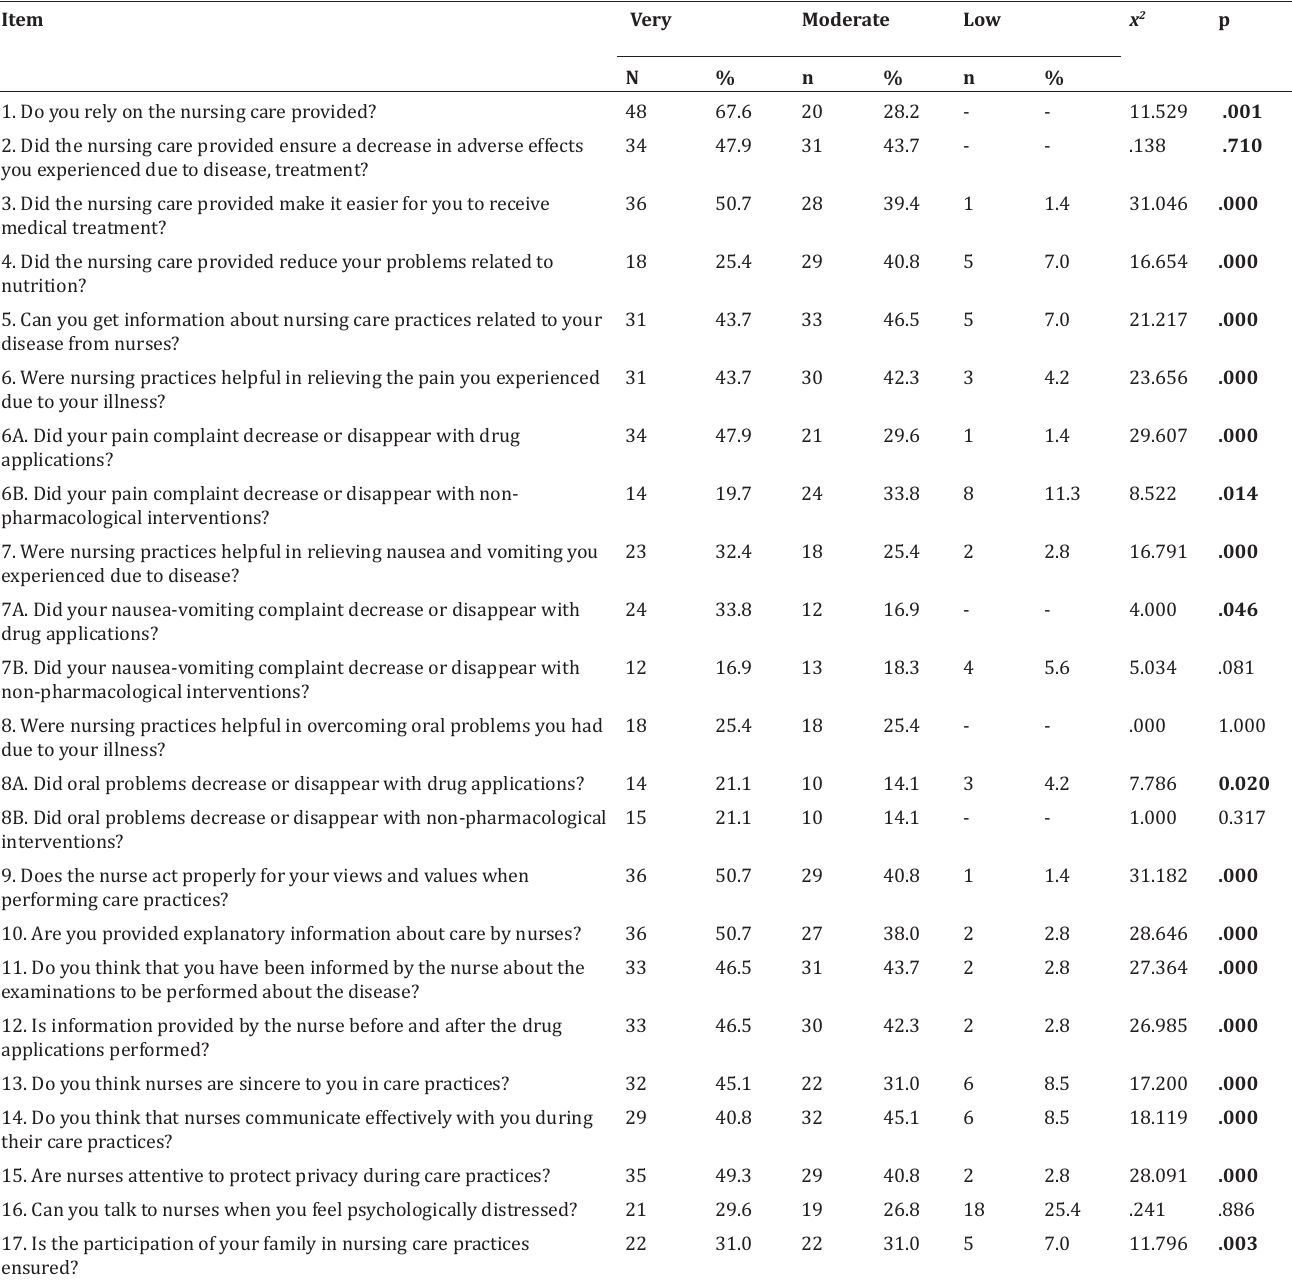
Table 2 Distribution of Patients' Views on the Grading of Care in the Questions Positively Answered by